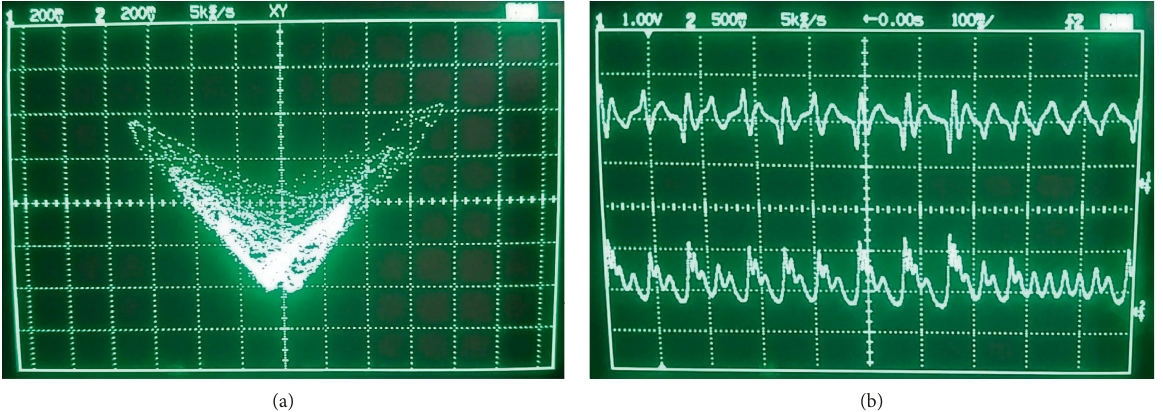
Figure 10: Simulation of ES in V2 of Liu and Chen in its DV by using τ variables x ( n ) and z ( n )